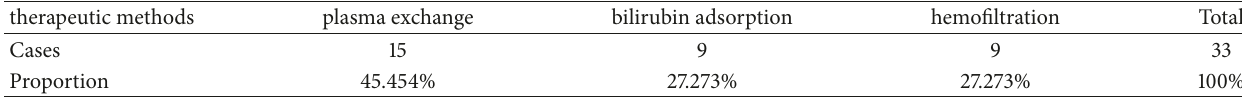
Table 3: Classification of chronic hepatic failure with different patterns of nonbioartificial liver treatment.